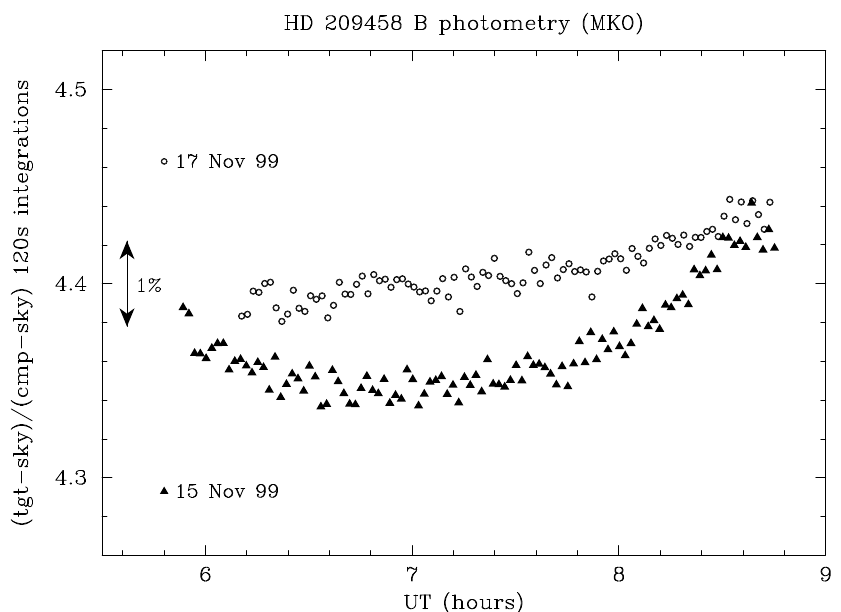
Fig. 2. Sky-corrected target/comparison star ratio data for the nights of 15 and 17 November 1999. The effective integration time per point is 2